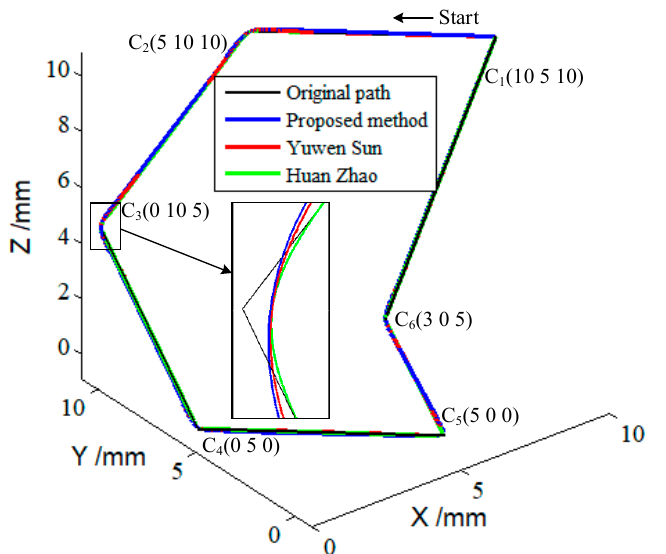
Figure 7. The 3D tool path using three methods.